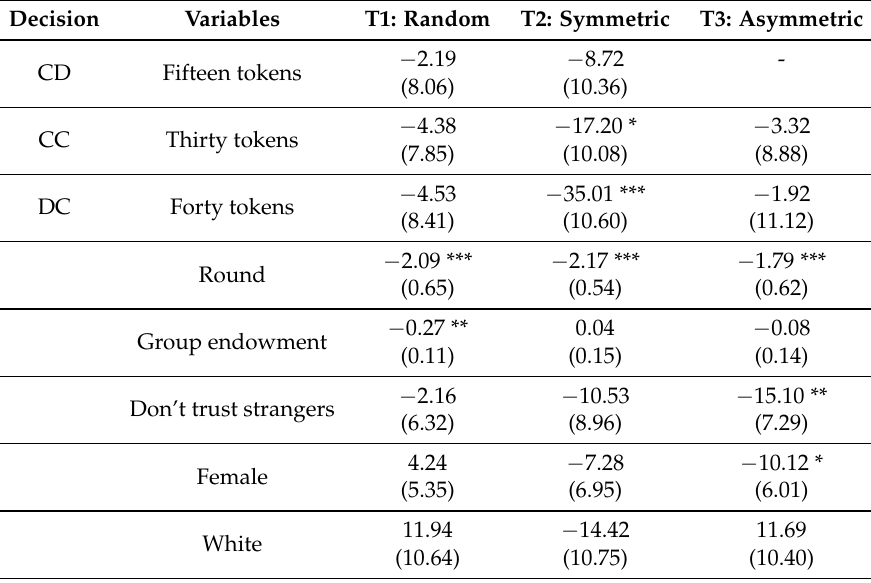
Table A3. Expanded Effects of the Origins of Wealth